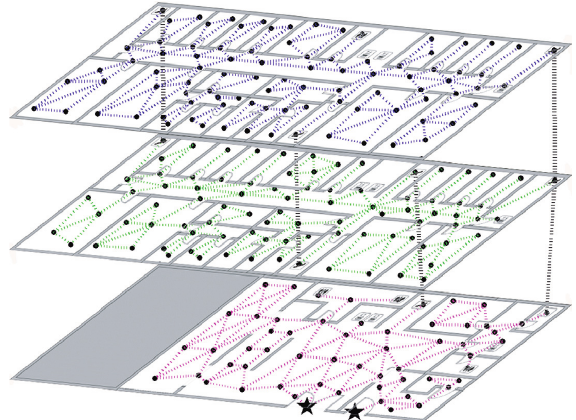
Figure 2: The graph-based layout of Imperial College’s EEE building. The black stars represent the exits on the ground